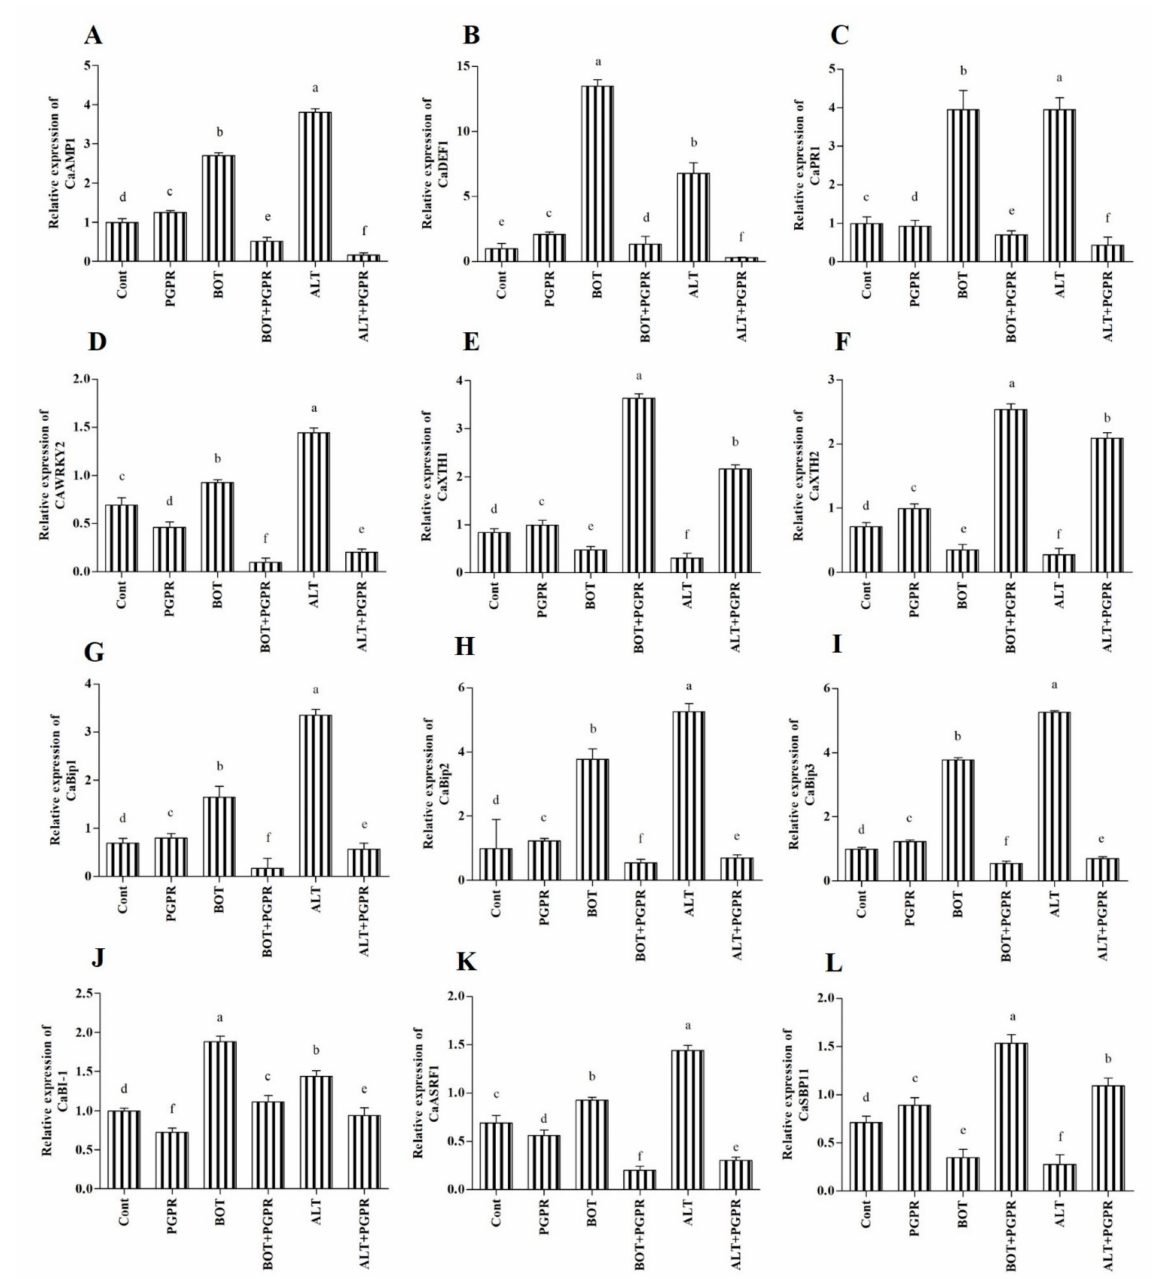
Figure 9. Real-time expression analysis of CaAMP1 ( A ), CaDEF1 ( B ), CaPR1 ( C ), CaWRKY2 ( D ), CaXTHs (CaXTH1; ( E ), and CaXTH2; ( F )), CaBiPs (CaBiP1; ( G ), CaBiP2; ( H ), and CaBiP3; ( I )), CaBI-1 ( J ), CaASRF1 ( K ), and CaSBP11 ( L ) in the leaves of peppers grown under normal and stress conditions and treated with plant growth-promoting rhizobacteria (PGPR) after eight days. Treatment: Cont (control), PGPR ( Bacillus amyloliquefaciens ), BOT ( Botrytis pelargonii ), PGPR + BOT ( Bacillus amyloliquefaciens + Botrytis pelargonii ), ALT ( Alternaria alternata ), PGPR + ALT ( Bacillus amyloliquefaciens + Alternaria alternata ). Values show the means ± standard error ( n = 3) and significant differences are indicated at p < 0.05 in accordance with the least significant difference test. Bars with different letters are significantly different from each